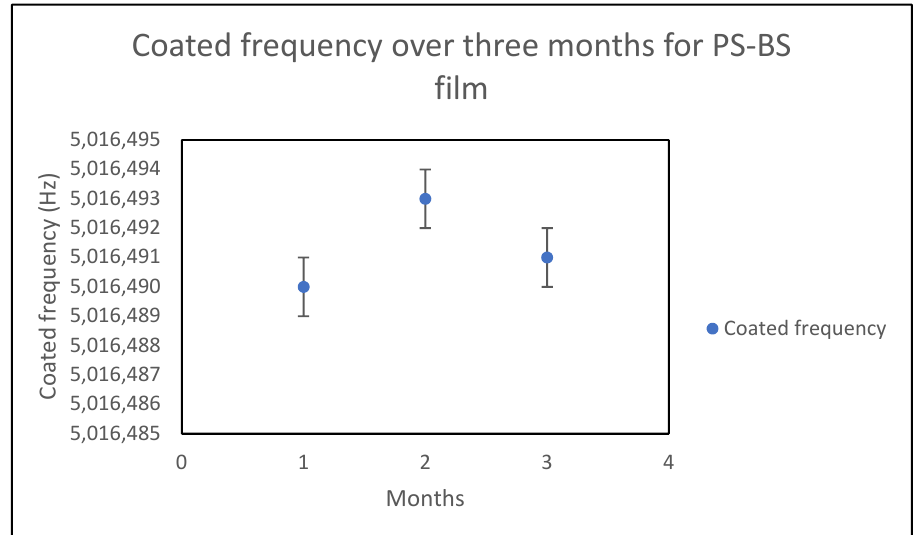
Figure 6. The shift in the coated frequency of the PS–BS (15%) film over three months.